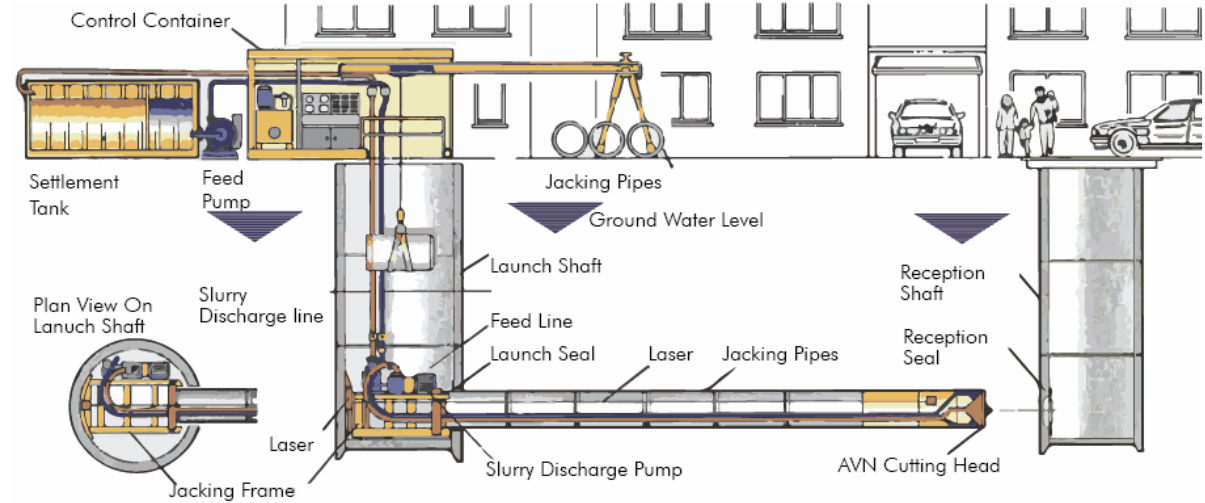
Figure 1: Typical microtunelling installation